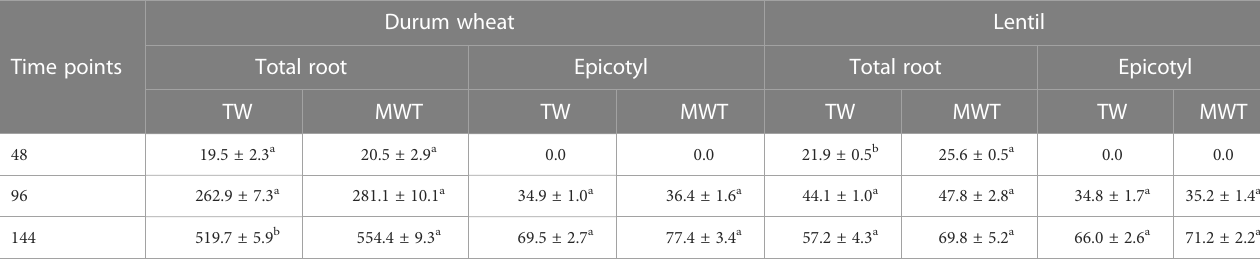
TABLE 2 ANOVA signi fi cance for growth parameters of durum wheat and lentil.